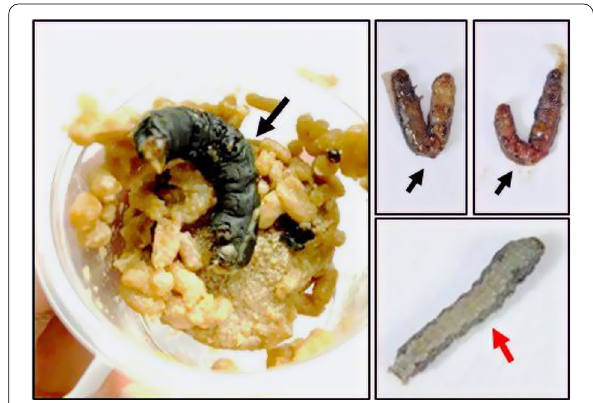
Fig. 1 Photographs showing the differences between infected Spodoptera littoralis fourth instar larvae (pointed by black arrows) and healthy larva (pointed by a red arrow) 7–10 days post infection (p.i). The infected S. littoralis larvae became visibly swollen with fluids as typical baculovirus infection